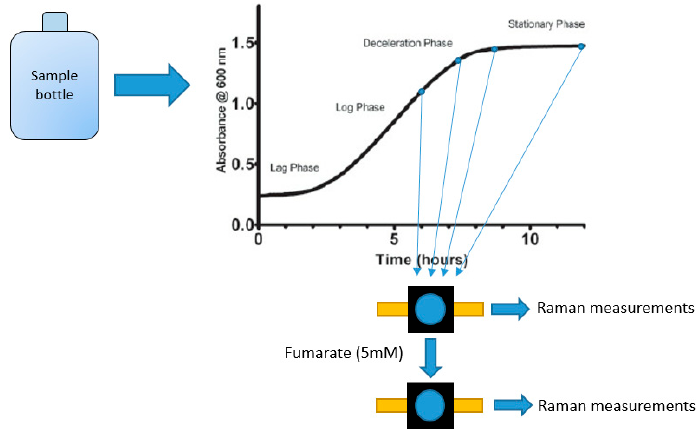
Figure 10. Schematic of the sampling process used for suspended cell Raman measurements.